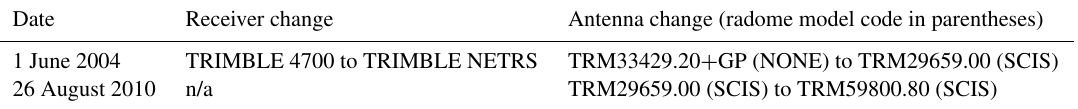
Figure 1. (a) Relief map of the area surrounding the GPS station SG27, produced using a lidar data set collected in August 2012 (Wilson et al., 2014). The x and y axes show horizontal and vertical positions relative to SG27 in UTM Zone 4N. The red dashed fan shape outlines the estimated footprint of the GPS reflected signals (see Sect. 4.2). (b) Permafrost extent in Alaska (after Brown et al., 1997). The red triangles denote the PBO GPS stations located in the permafrost areas. (c) Aerial photograph over the facilities of the NOAA Barrow Observatory and SG27 (photo: NOAA). The red dashed lines denote the western portion of the footprint. (d) A close-up photograph of SG27, viewing from the north (photo: Elchin Jafarov, August 2013). Table 1. History of equipment changes at SG27. The equipment codes follow the International GNSS Service convention (ftp://ftp.igs.org/